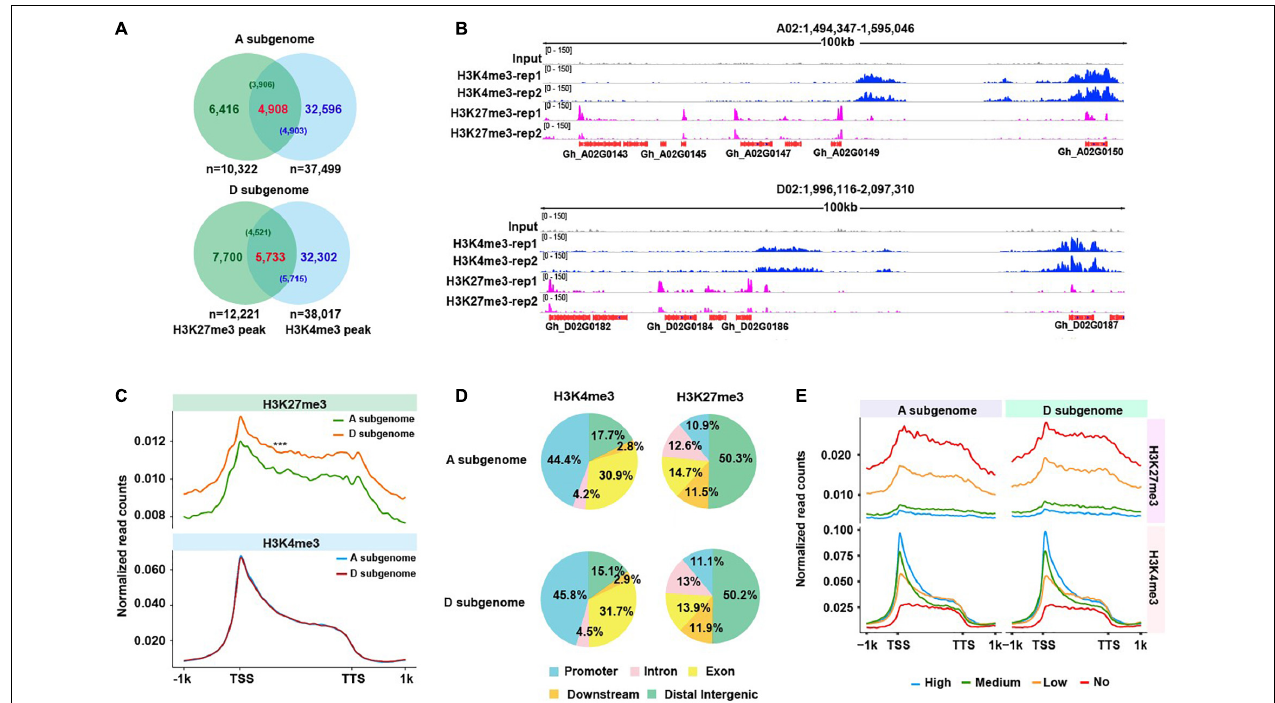
FIGURE 1 | Distribution of H3K4me3 and H3K27me3 marks. (A) Venn plots illustrating overlaps of H3K4me3 and H3K27me3 peaks, and H3K4me3/H3K27me3 bivalents identified from A and D subgenome, respectively. The number in each bracket represents the number of H3K4me3 (or H3K27me3) peaks that overlap with H3K27me3 (or H3K4me3). (B) Representative IGV snapshots across a 100 kb window from chromosome A02 and chromosome D02 show the enrichment of H3K4me3 and H3K27me3 peaks in the A and D subgenomes. (C) Curve plots show the profile of normalized H3K4me3 and H3K27me3 read counts from 1 kb upstream of the TSSs to 1 kb downstream of the TTSs across all genes from two subgenomes. A significance test was determined using the Wilcoxon rank-sum test, *** p < 0.001. (D) Distribution of H3K4me3 and H3K27me3 in different functional sub-genomic annotations, namely, promoters (upstream 2 kb), exons, introns, downstream (2 kb) and distal intergenic regions. (E) Curve plots show the profile of normalized H3K4me3 and H3K27me3 read counts from 1 kb upstream of the TSS to 1 kb downstream of the TTS of all genes from the A and D subgenomes. All genes were divided into four subtypes according to their FPKM values (high, medium, low, and no